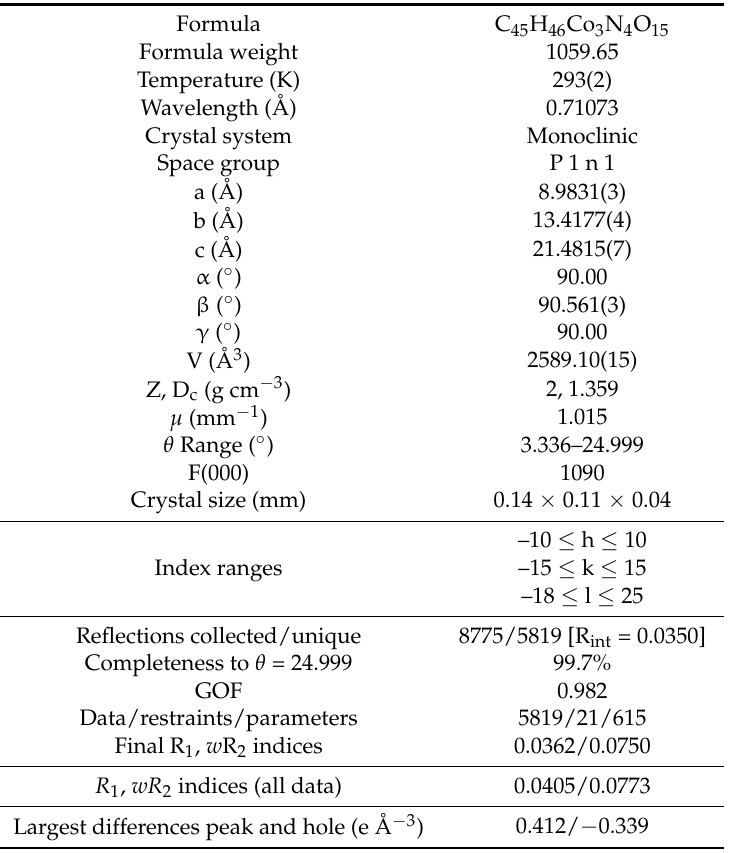
Table 1. Crystal data and structure refinement parameters for the Co(II)